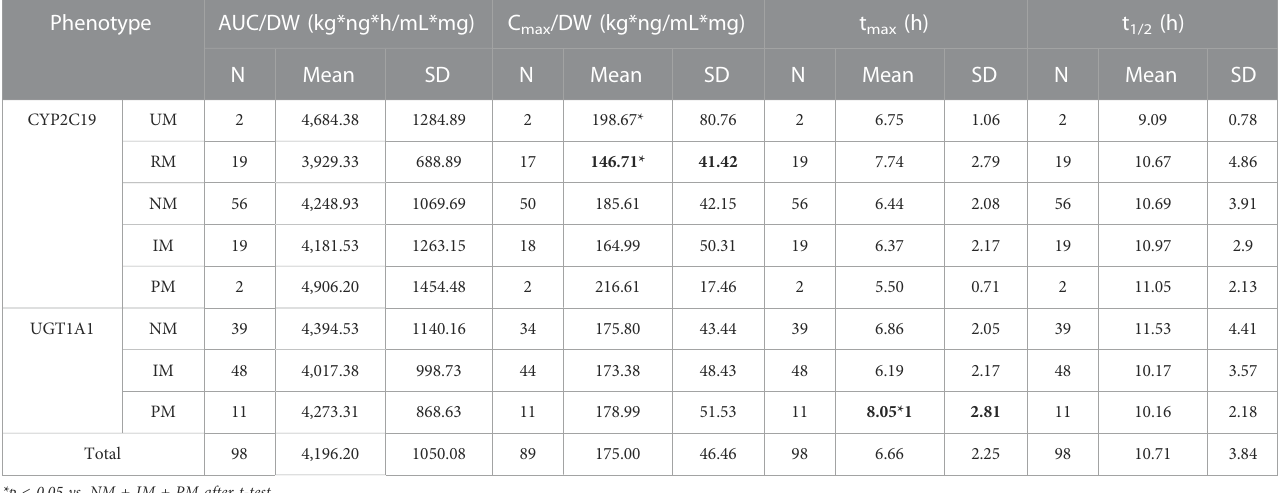
TABLE 5 Signi fi cant associations between CYP2C19 and UGT1A1 phenotypes and the pharmacokinetic parameters of desvenlafaxine.